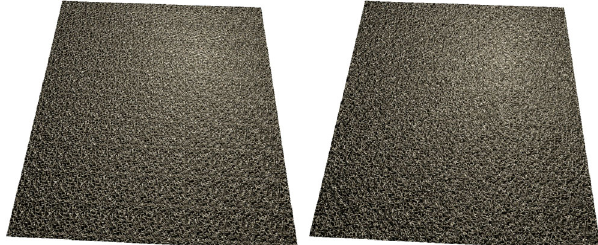
Fig. 9 Left: periodic pattern caused by repeating the same texture 10 times in both dimensions. Right: the same tiling rendered with randomly distributed seamless texture variations.